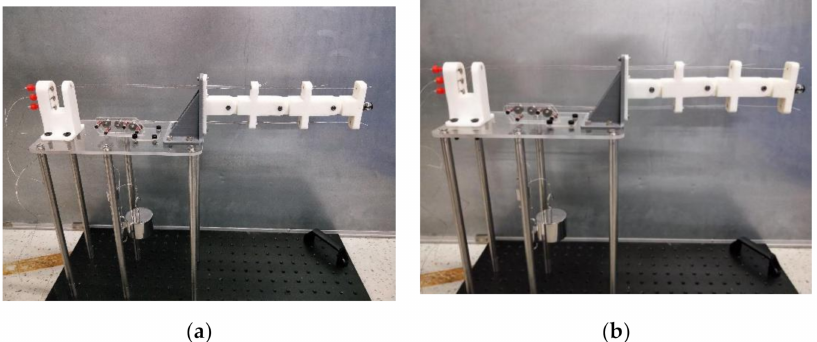
Figure 12. Manipulators in a singular state. ( a ) Initial configuration under a singular state; ( b ) adding − 1 mm cable length error under a singular